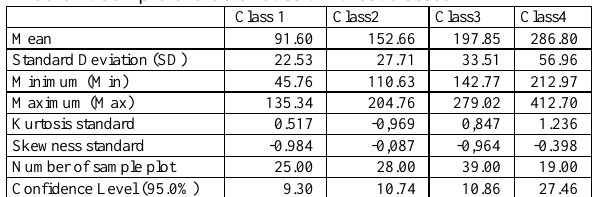
Table 4. Sample characteristics of forest classes Class 1